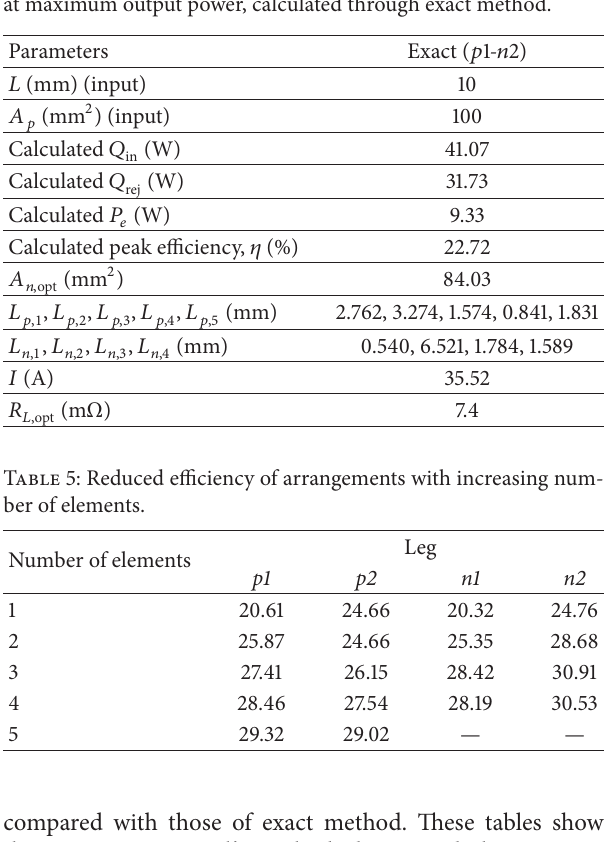
Figure 5: Variation of reduced efficiency versus 𝑢(𝑇 solid and dashed lines indicate results of exact and approximate method, respectively.